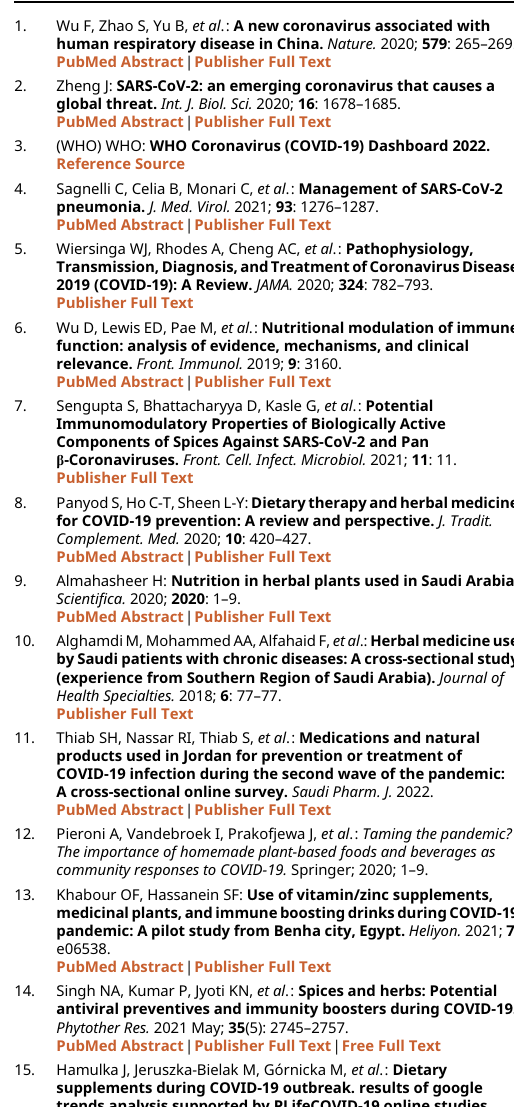
- Natural products Raw Data.xlsx (survey responses from all